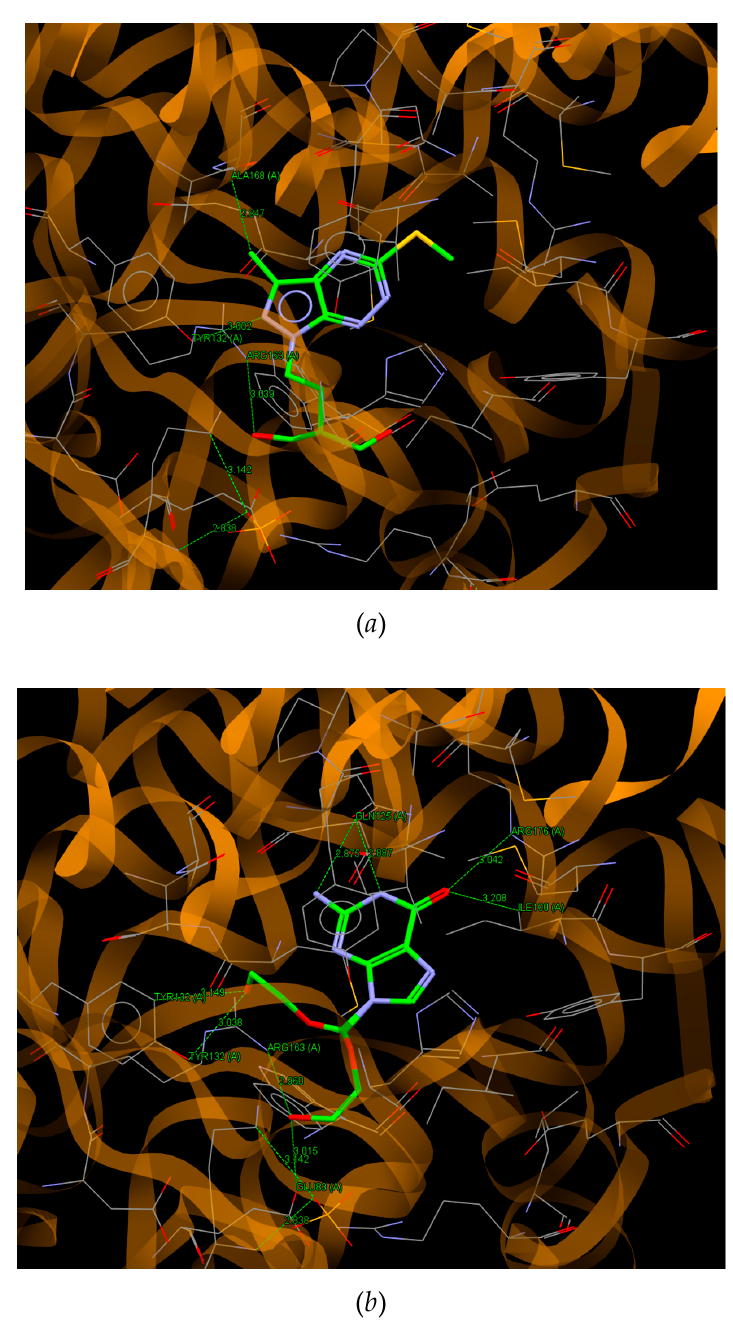
Figure 5. A view of the interaction of ( a ) 8 and ( b ) Ac with amino acids of binding site in TK.